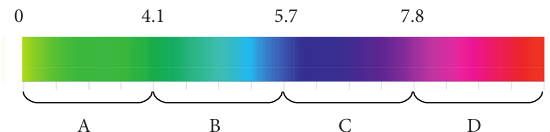
Figure 17: Pavement performance chromatogram of the Dalian highway